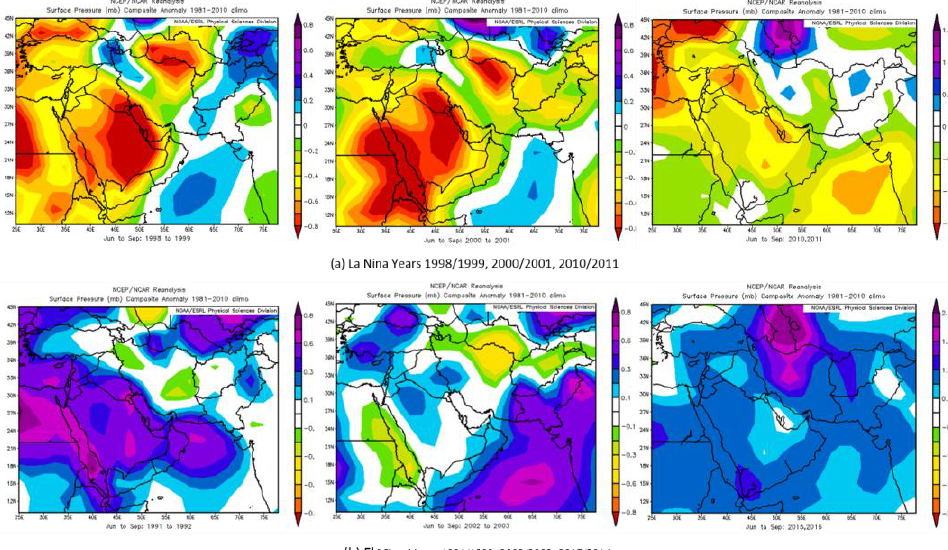
Figure 15. The seasonal mean surface atmospheric pressure anomalies obtained from NCEP Reanalysis-2 for ( a ) La Nina years 1998/1999, 2000/2001, 2010/2011, and ( b ) El Nino years